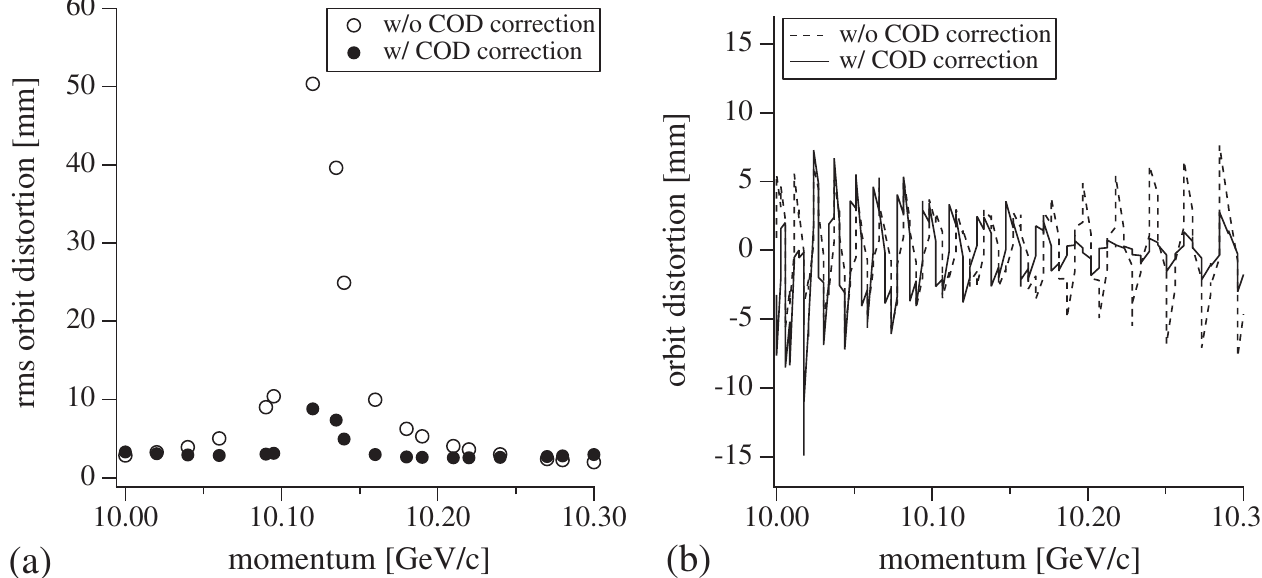
FIG. 18. (a) The rms closed orbit distortion with and without COD correction. (b) Orbit distortion of an accelerating particle with and without COD